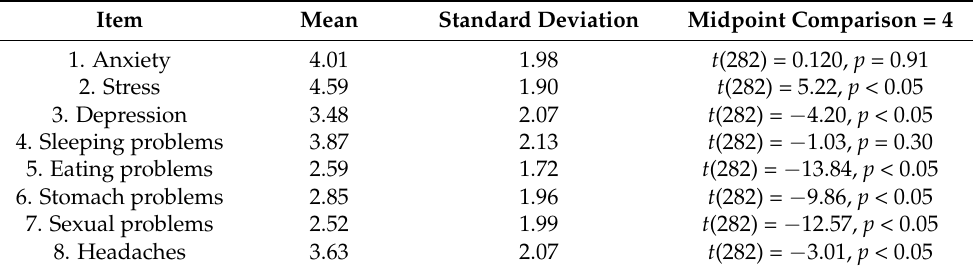
Table 4. Descriptive statistics and comparisons with the middle point of the scale of mental and physical health symptoms in the sample of migrants. Item Mean Standard